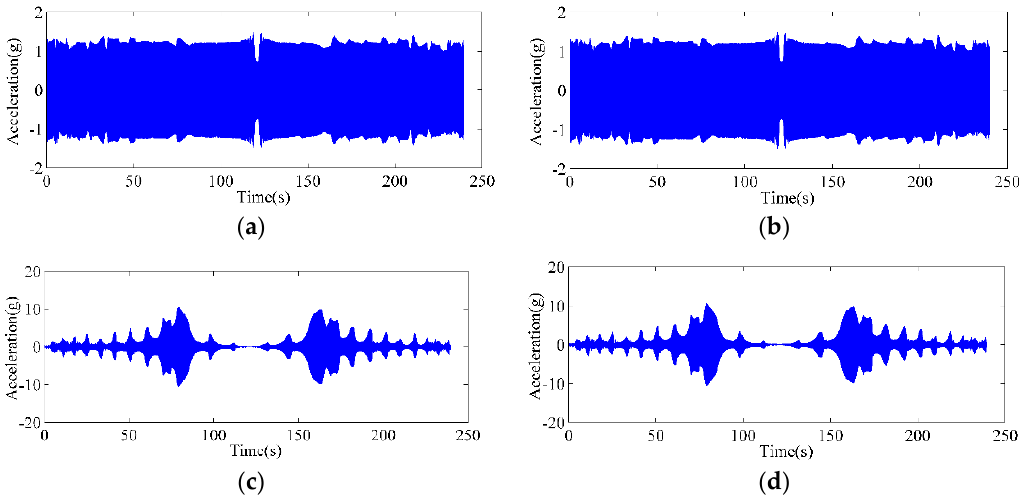
Figure 5. Time-domain waveforms of accelerations: ( a ) acceleration of the vibrator before any strands were broken; ( b ) acceleration of the vibrator after one strand was broken; ( c ) acceleration of the ACSR before any strands were broken; ( d ) acceleration of the ACSR after one strand was broken.